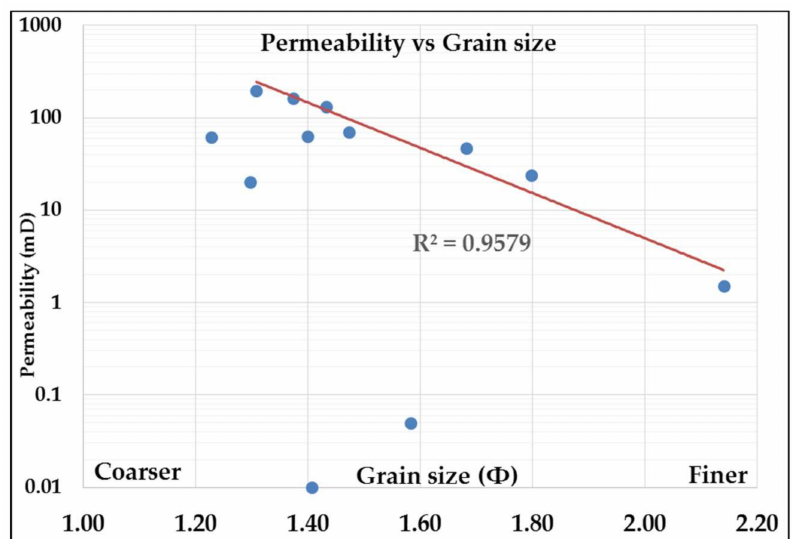
Figure 5. Relationship between petrophysical parameters (porosity and permeability) and grain size